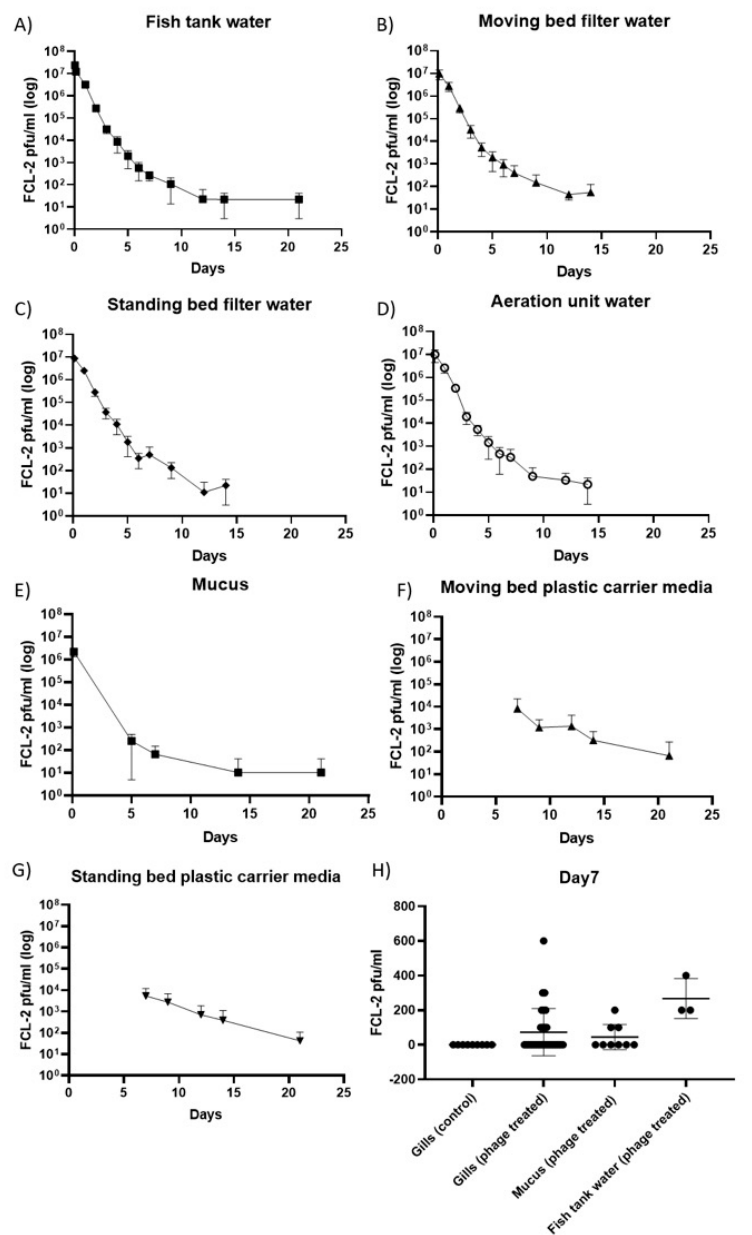
Figure 1. Phage persistence over time in the recirculating aquaculture system (RAS) tanks and fish. Phage FCL-2 titers (pfu / mL) on ( A ) the fish tank water, ( B ) the moving bed water, ( C ) the fixed-bed water, ( D ) the aeration unit water, ( E ) fish mucus, ( F ) the moving bed plastic carrier media, ( G ) the fixed-bed plastic carrier media, ( H ) on fish gills (seven days after phage exposure). In A , B , C, and D, each tank was sampled once until day seven and in triplicates from day nine onwards. In E, three fish per tank were sampled in the first and fifth day, then three fish per control tank, and ten fish per phage-treated tank were measured from day seven onwards. In F and G, five carrier media pieces per tank were sampled in all time points. In H, three fish from each control tank and ten fish from each phage treated tank were